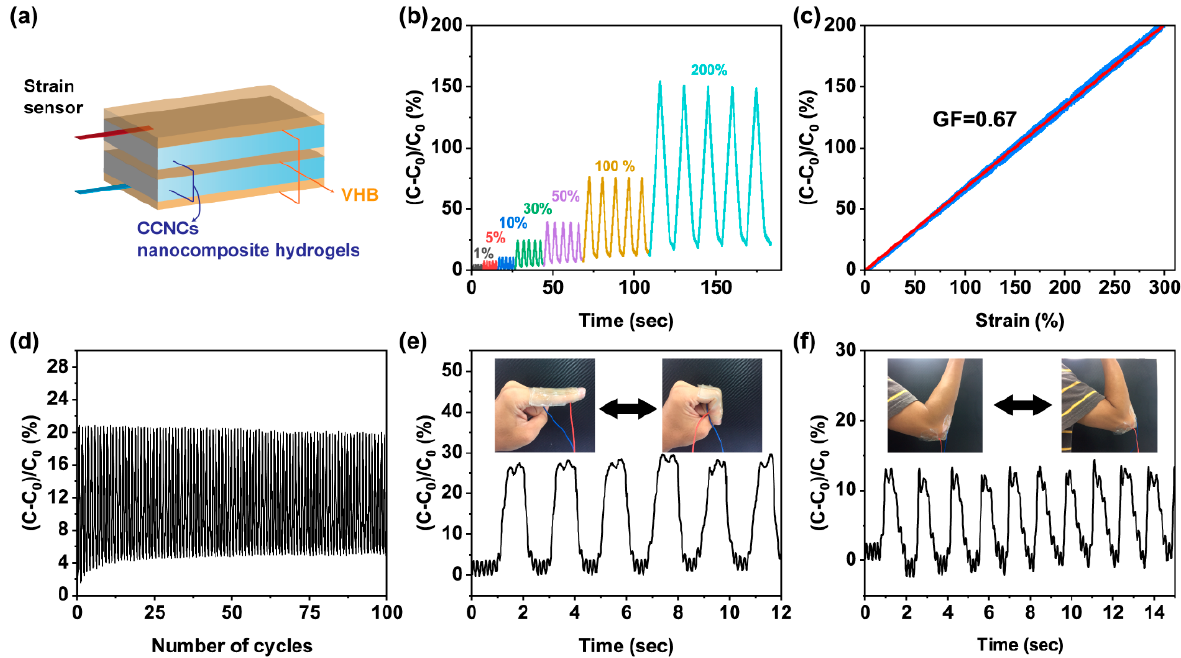
Figure 8. Performance of the 3D printed strain sensor. ( a ) The assembly of the strain sensor. ( b ) Relative capacitance change of the sensor under different strains. ( c ) The dependence of relative capacitance change on the strain. The red line was the linear fitting of the gauge factor in the range of strain from 0 to 300%. The R 2 value of the linear fitting was 0.99. ( d ) Relative capacitance change of the sensor at 30% strain for 100 cycles. ( e , f ) The relative capacitance change when the sensor was attached to the finger and elbow.